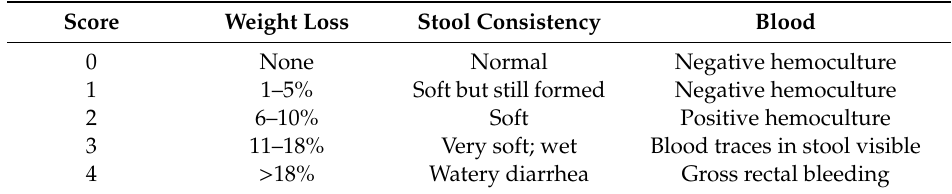
Table 1. Scoring system to calculate disease activity index based on weight loss, stool consistency, and the degree of intestinal bleeding. Score Weight Loss Stool Consistency Blood 0 None Normal Negative hemoculture 1–5% Soft but still